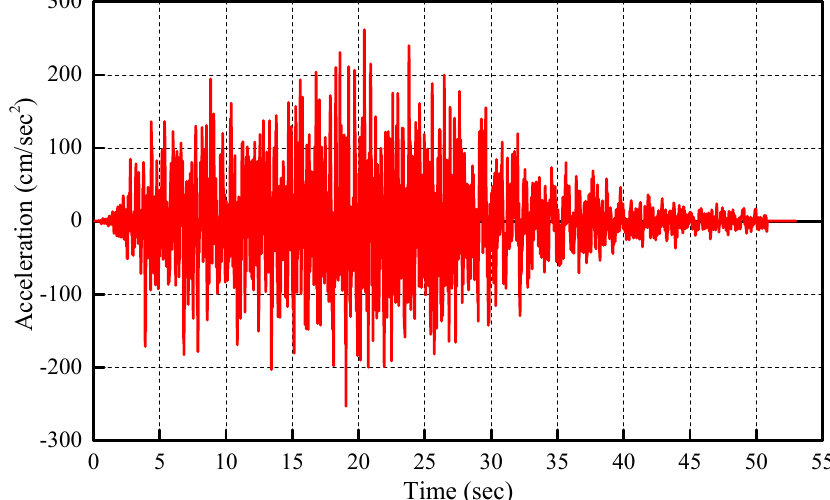
Figure 12. Artificial seismic wave.